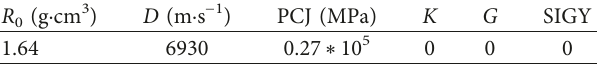
Table 2: High-explosive-burn parameter.